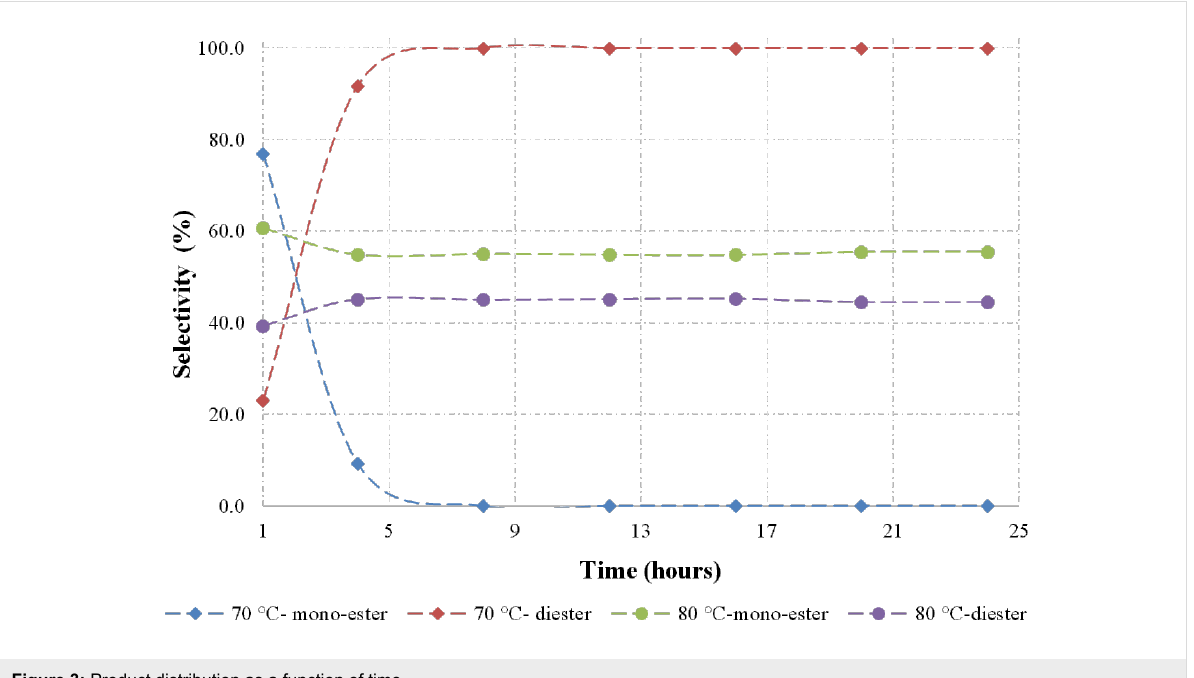
Figure 3: Product distribution as a function of time.